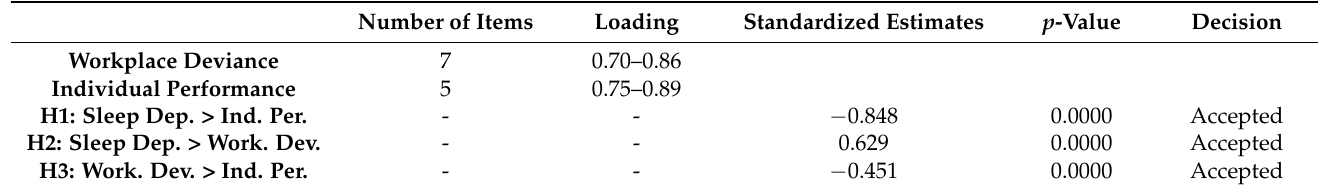
Table 5. Testing of Hypotheses and Loadings (Direct Effect).